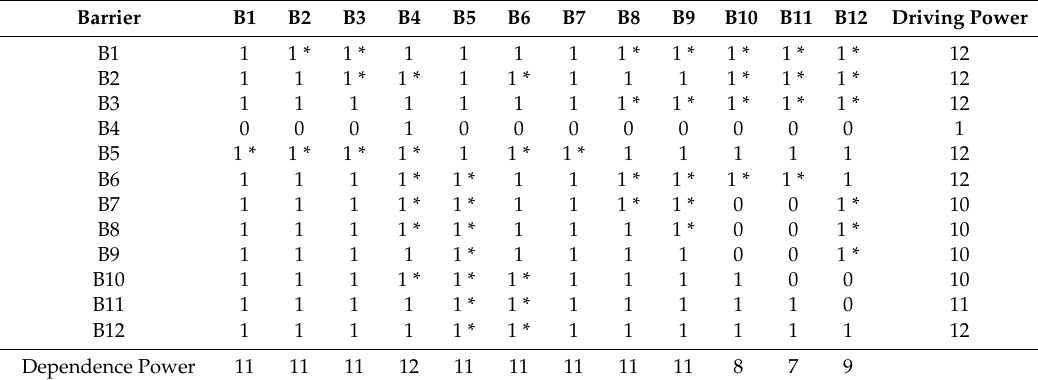
Table 4. The final reachability matrix (FRM).